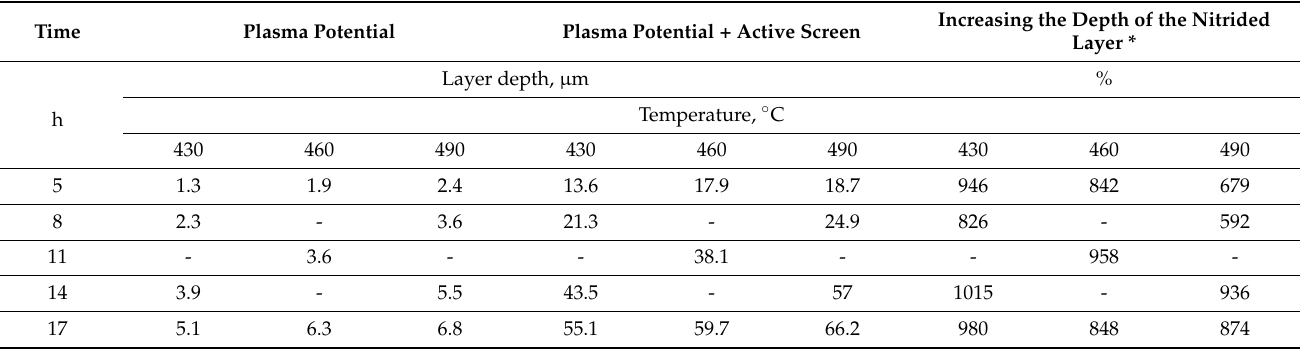
Table 3. The depth of nitrided layers on the 316L steel substrate depending on the location of the samples in the glow